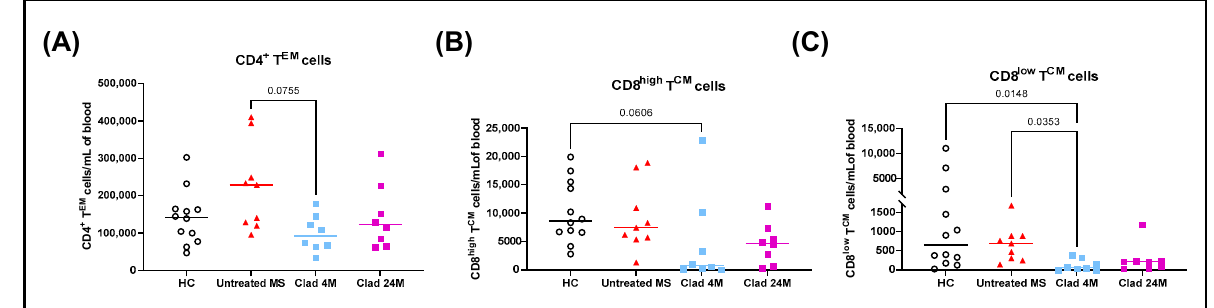
Figure 3. Cladribine depletes CD4 + T EM and CD8 + T CM cells. Blood was sampled from healthy controls ( n = 12), untreated MS ( n = 9) and cladribine-treated MS patients at 4 months ( n = 8) and 24 months ( n = 8) post initial dose. Upon sample collection, fresh PBMC were immediately isolated and phenotyped. Each T cell subset was gated on to calculate the proportion of cells multiplied by the cell count and shown as cells per mL of blood. The peripheral blood concentration of ( A ) CD4 + T EM cells ( B ) CD8 high T CM cells and ( C ) CD8 low T CM cells. Kruskal–Wallis with Dunn’s multiple comparisons test. Median and p -values ≤ 0.1 are shown. T CM , central memory T cells; T EM , effector memory T cells; HC healthy controls; MS, multiple sclerosis; Clad, cladribine; 4M, 4 months post-Clad; 24M, 24 months post-Clad; PBMC, peripheral blood mononuclear cells.